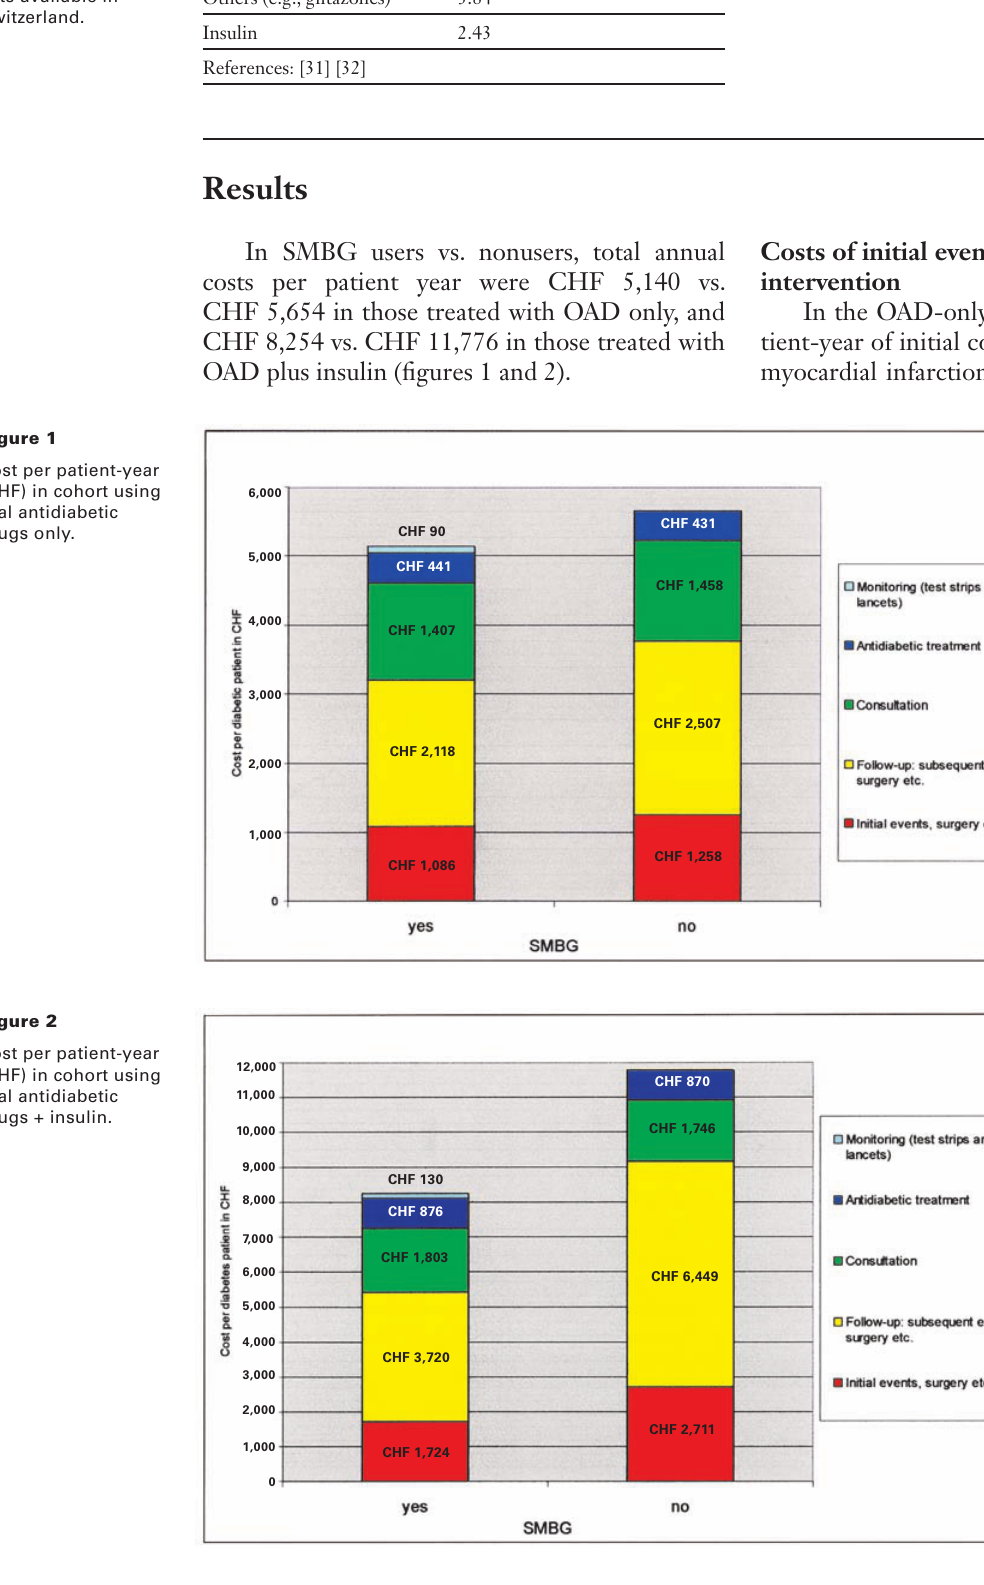
Weighted cost of rec- ommended daily dosages (CHF) of an- tidiabetic medication averaged from prod- ucts available in Switzerland.